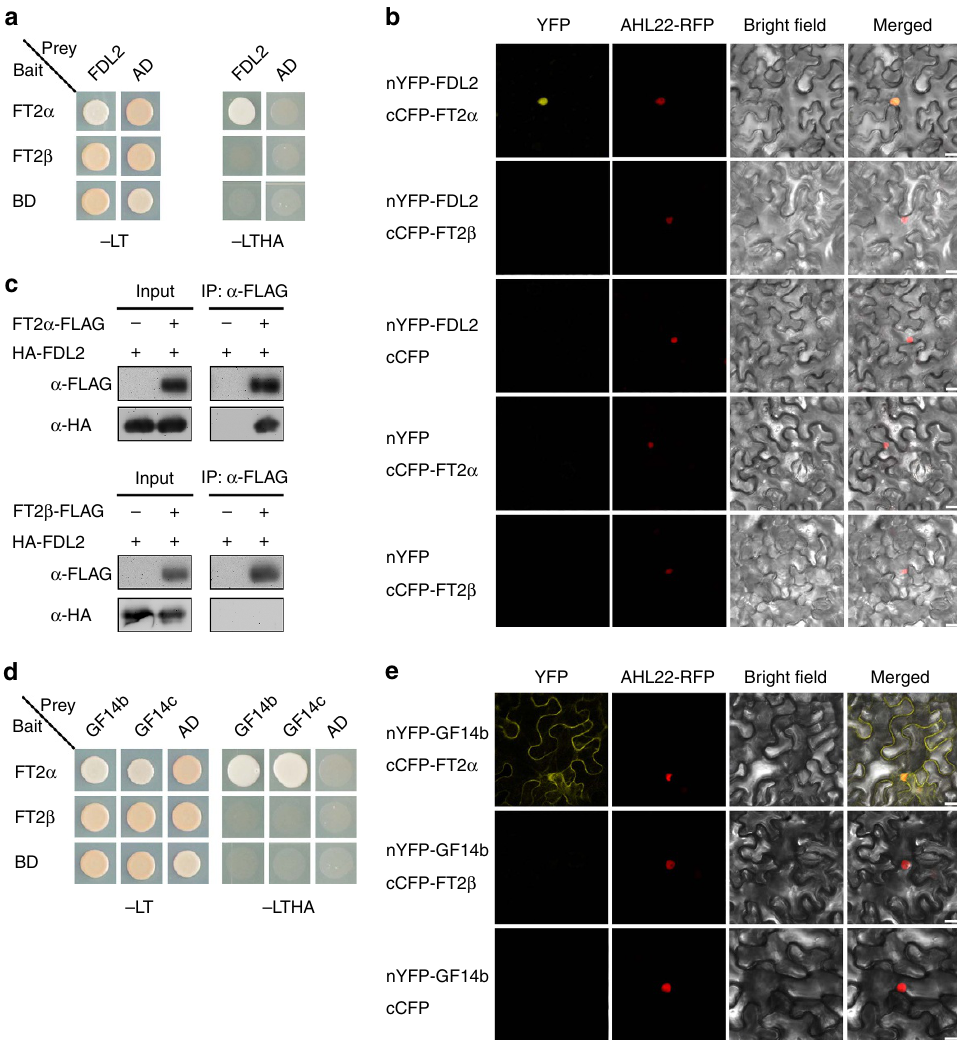
Figure 2 | Interaction analysis of FT2 a and FT2 b with FD-like and 14-3-3 proteins. ( a ) Interaction analysis of FT2 a and FT2 b with FD-like protein (FDL2) in yeast cells. Yeast cell growth on selective media without Leu, Trp, His and Ade ( (cid:2) LTHA) indicates positive interactions. ( b ) BiFC interaction assays of FT2 a and FT2 b with FDL2. Partial YFP fusion constructs were expressed transiently in N. benthamiana leaves. AHL22-RFP was used as a nuclear marker. Scale bar, 20 m m. ( c ) In vivo Co-IP assays of two FT2 splicing isoforms with FDL2. FLAG-tag FT2 a or FLAG-tag FT2 b were co-expressed with HA-tag FDL2 in N. benthamiana leaves. ( d ) Yeast two-hybrid analyses of interactions between FT2 isoforms and two 14-3-3 proteins (GF14b and GF14c). ( e ) BiFC interaction assays of FT2 a and FT2 b with 14-3-3 protein GF14b. Scale bar, 20